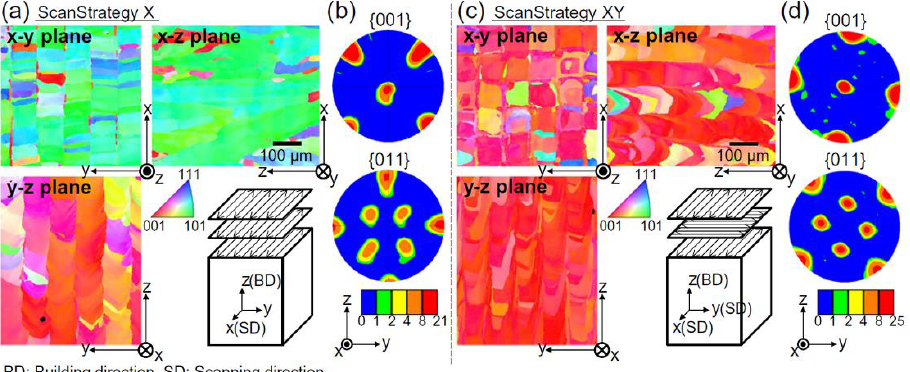
Figure 5. ( a , c ) Inverse pole figure (IPF) images from the three orthogonal planes. ( b , d ) (001), and (011) pole figures of the Ti parts measured in the y–z plane. BD is the building direction and SD is the scanning direction. (Reproduced with permission from ref. [68]. Copyright (2017), Elsevier).